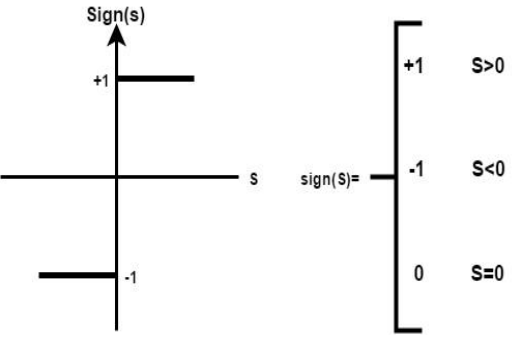
Fig. 3. The shape of a signum function